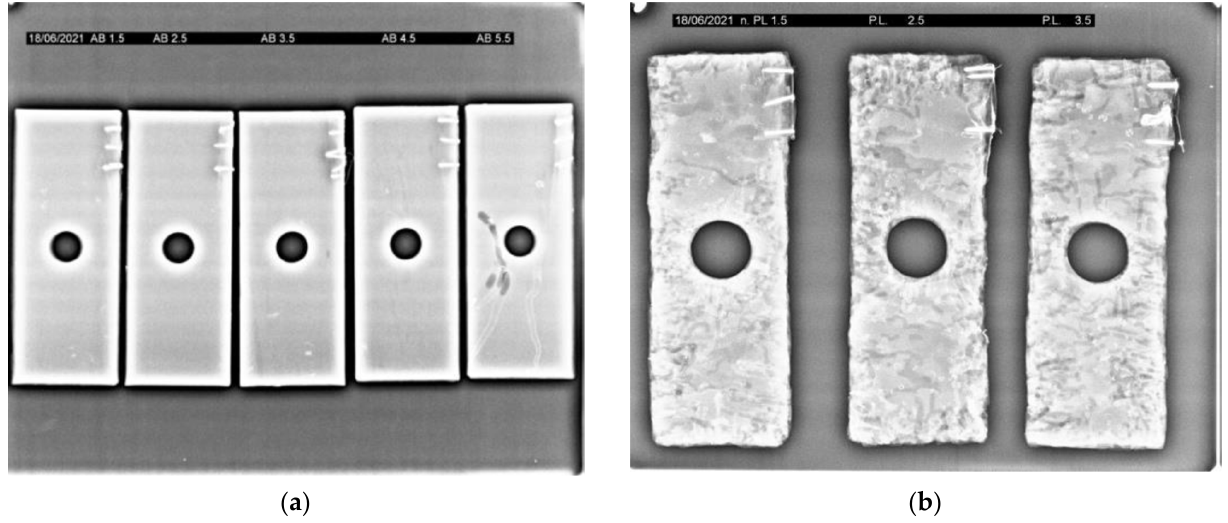
Figure 1. ( a ) Set of acetylated European beech samples; ( b ) set of acetylated MDF samples, from the last evaluation in Venice.